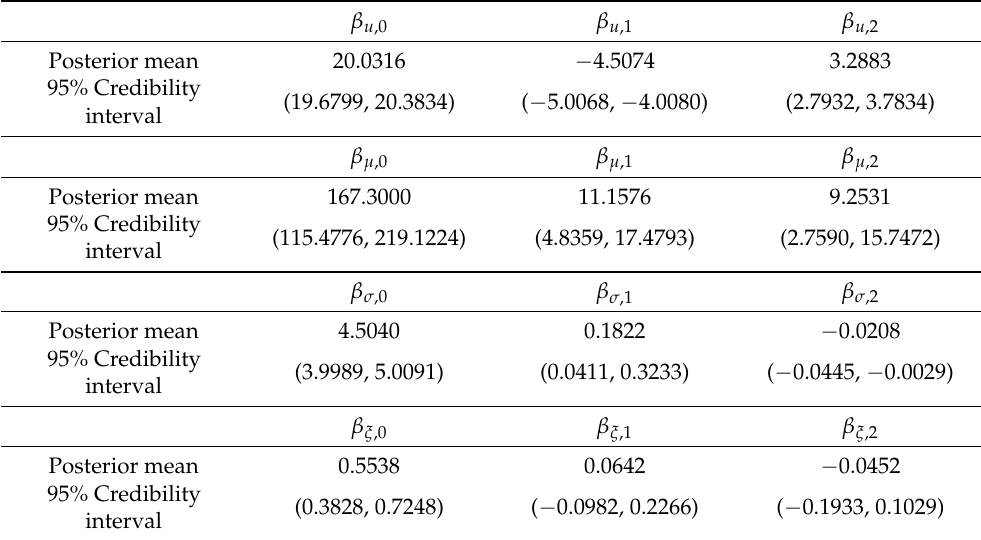
Table 5. Estimates and 95% credibility interval for the regression coefficients of the Patuxent river daily